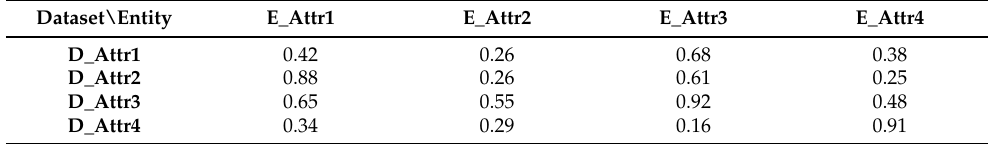
Table 4. Example 1: Attributes-pairs matrix with similarity scores calculated by one